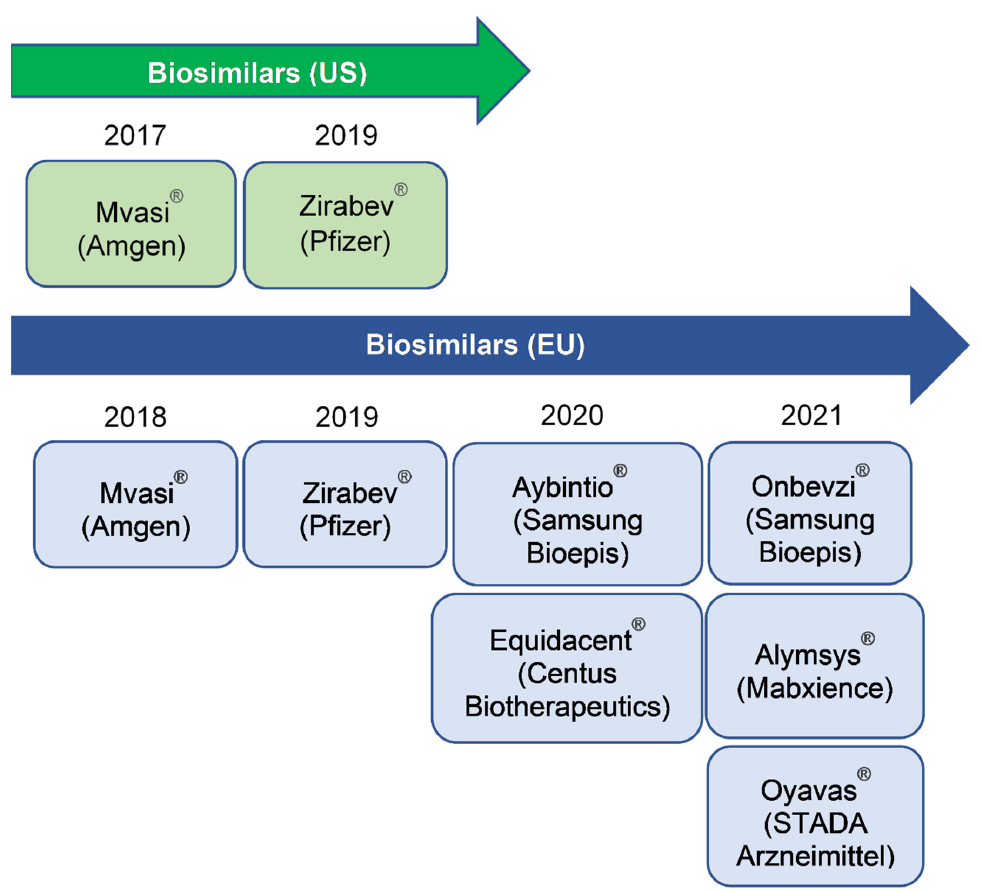
Figure 1. Biosimilars for Bevacizumab in US and EU, and their approval